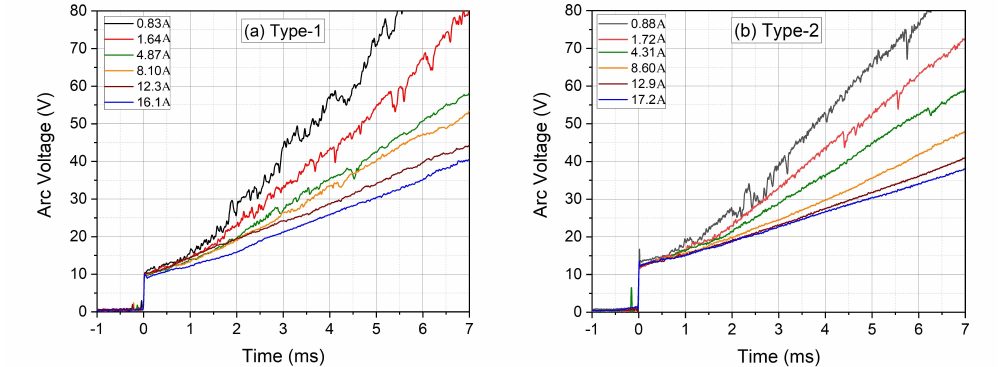
Figure 9. Arc voltage waveforms at constant currents for 7 ms after contact separation of ( a ) Type-1 contacts; ( b ) Type-2